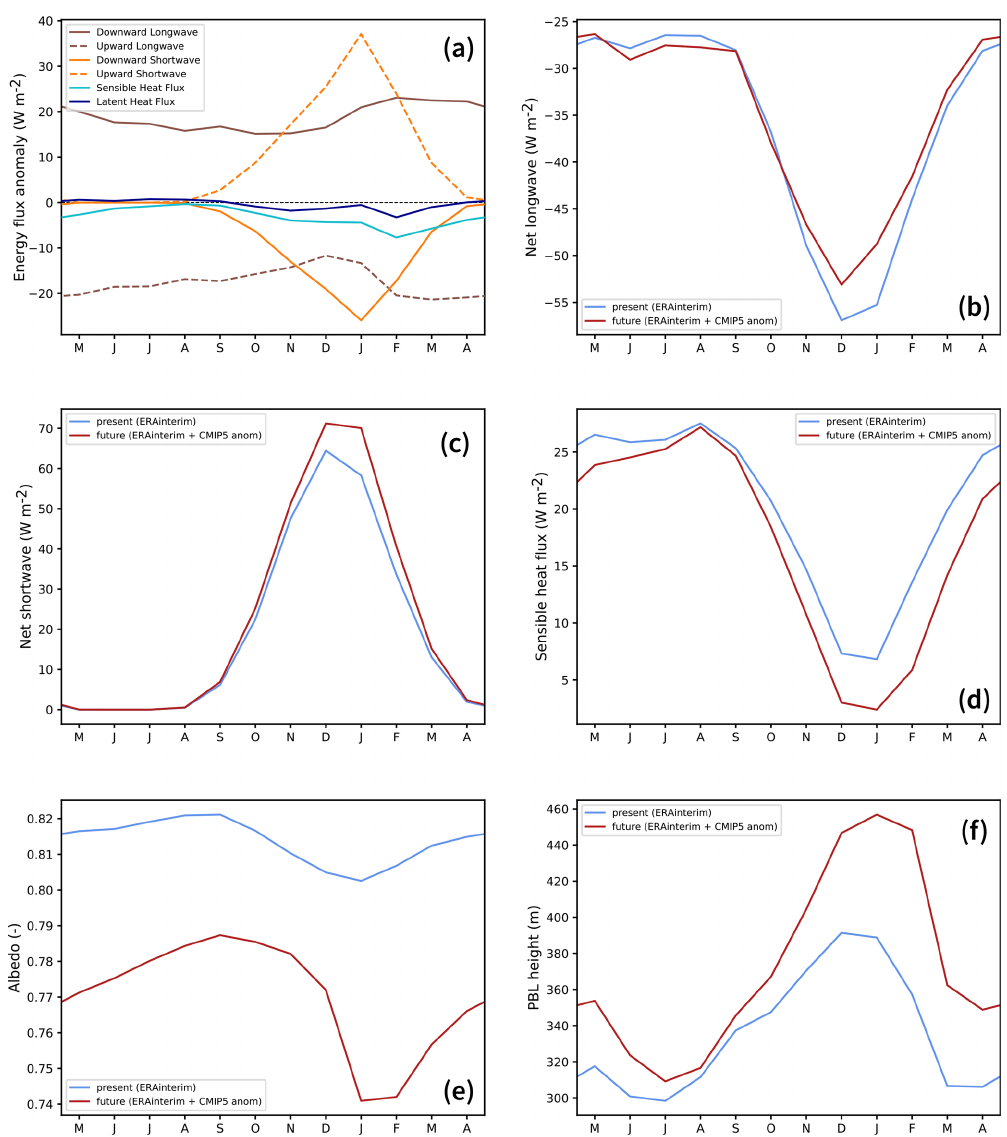
Figure 8. (a) Seasonal cycle of the anomaly (future minus present) in energy fluxes received by the ice-shelf surface (averaged over the seven major ice shelves from Getz to Abbot and positive if received by the surface). Present and future (b) net longwave radiative, (c) net shortwave radiative, and (d) sensible heat fluxes received by the ice-shelf surface. Mean present and future (e) albedo and (f) planetary-boundary-layer (PBL) height averaged over the seven major ice shelves from Getz to Abbot. The PBL height is calculated online in MAR from the vertical profile of horizontal turbulent kinetic